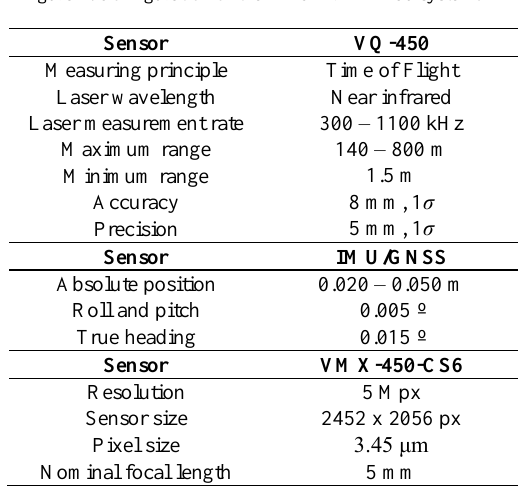
Figure 1. Configuration of the RIEGL VMX-450 system.